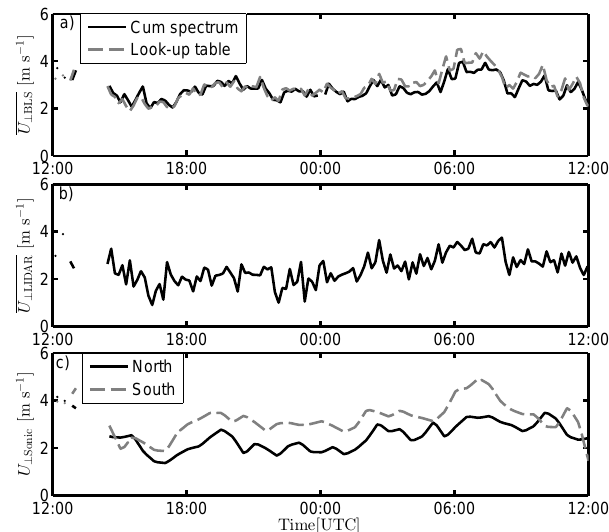
Figure 5. Time series of U ⊥ as estimated by (a) the scintillometer, (b) the Doppler lidar, and (c) the sonic anemometer for DOY 279 and